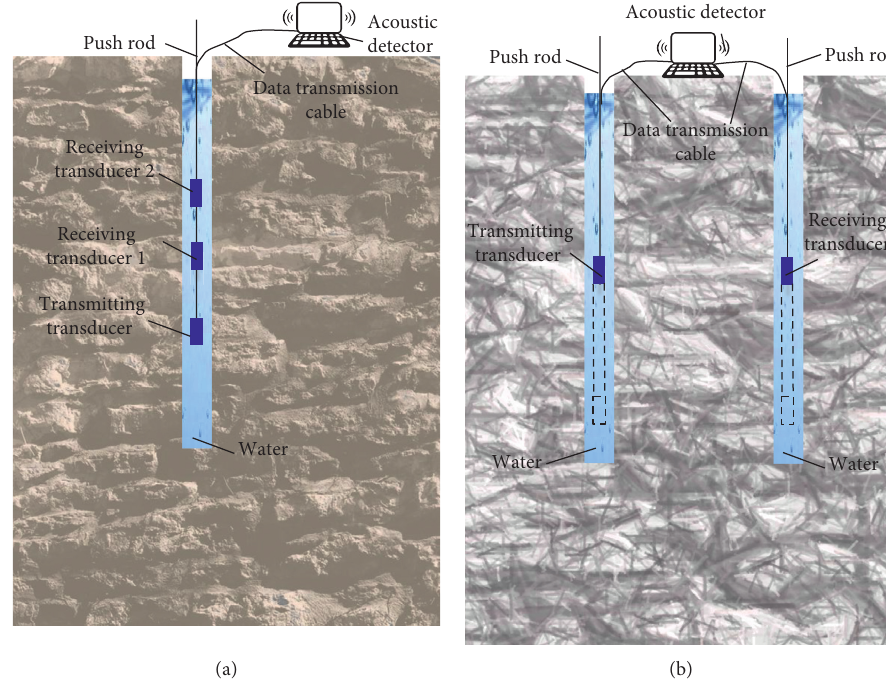
Figure 2: Principle of determining the depth of EDZ by acoustic testing. (a) Single hole acoustic test. (b) Cross hole acoustic